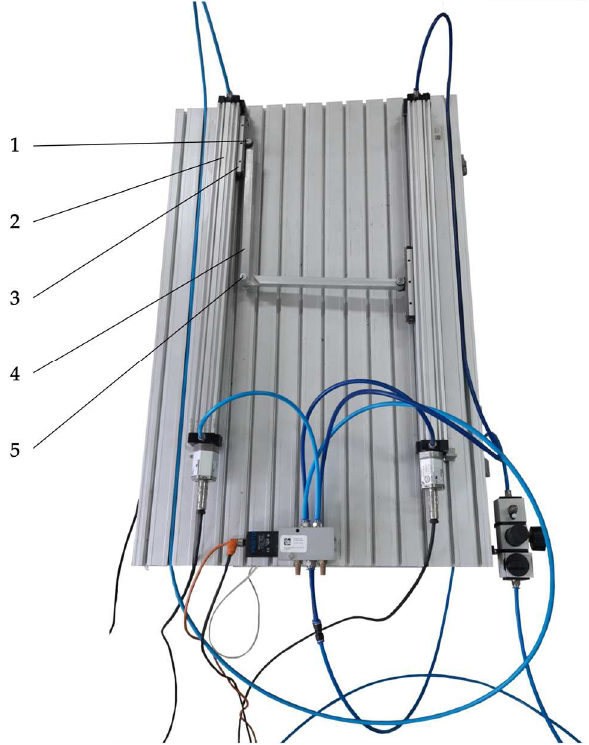
Figure 2. A general view of the prototype plane parallel pneumatic manipulator: 1—joint, 2—rodless actuator, 3—actuator slide, 4—manipulator arm, 5—end effector.